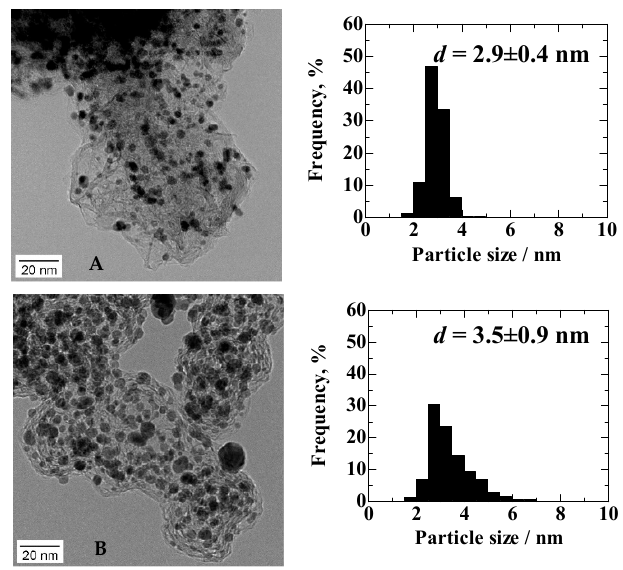
Figure 1. TEM images and particle size distribution histograms of pristine ( A ) Pt 2AL –PtFe/C and ( B ) c ‐ Pt 2 Ru 3 /C.